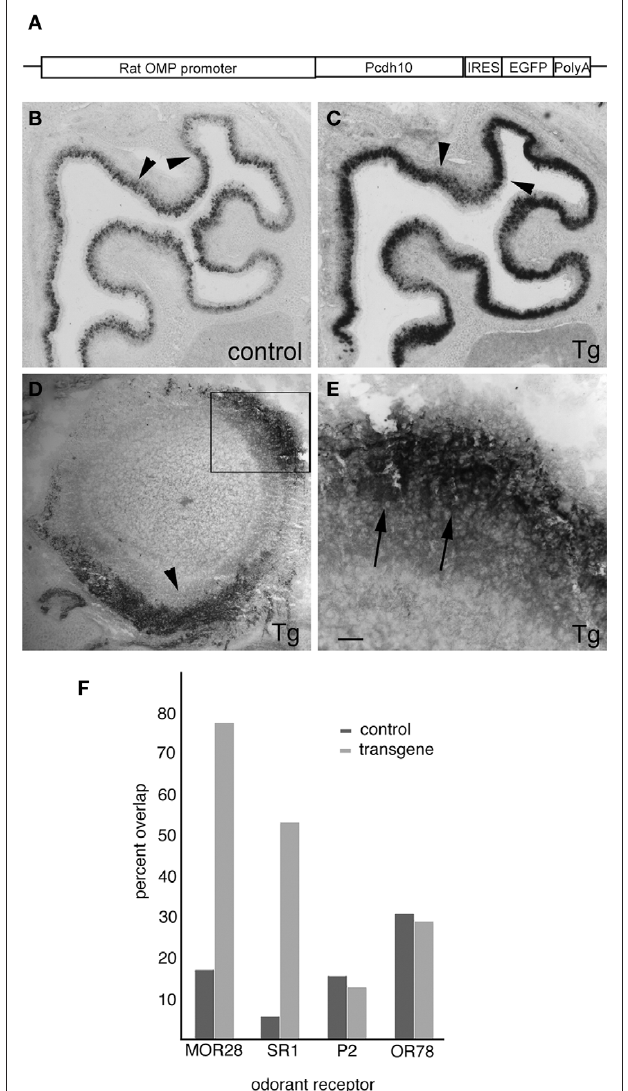
Figure 9 | expression of pcdh10 in OMP-pcdh10 transgenic animals. (A) Schematic of the plasmid used to generate the OMP - pcdh10 transgenic mutant. (B) In situ hybridization to detect pcdh10 expression in control (B) and transgenic (C) animals. Note that misexpression is not uniform throughout the epithelium. Misexpression of pcdh10 is patchy in areas where strong pcdh10 expression is present in control animals [compare arrowheads in (B) and (C) ]. (D) Immunohistochemical detection of pcdh10 protein in olfactory bulbs of transgenic animals. Medial is to the right. Strong axonal and glomerular signal can be detected, but this expression is not uniform. Expression is highest along the dorsomedial and ventral aspects of the bulb (arrowhead). (e) Higher magnification of boxed area shown in (D) demonstrating protocadherin expression in glomeruli (arrowheads). Image has been rotated to better illustrate glomerular signal. (F) Quantitation of double-label in situ hybridization with pcdh10 and MOR28 [45/58 (Tg), 4/23 (control)], SR1 [8/15 (Tg), 1/17 (control)], OR78 [7/24 (Tg), 9/15 (control)], and P2 (odorant receptors in control and transgenic animals). Scale bar = 200 μm (B,C) , 100 μm (D) , 32 μm (e)